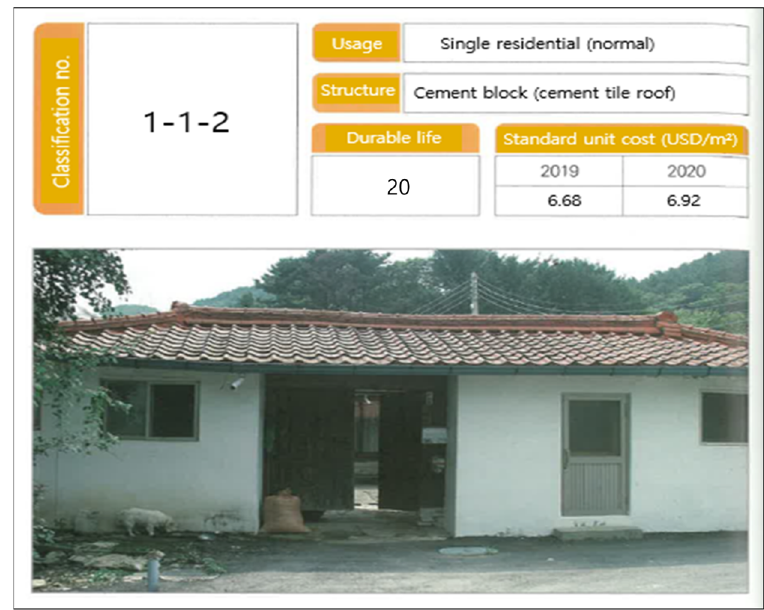
Figure 3. Durable life and standard unit cost for building unit price index.